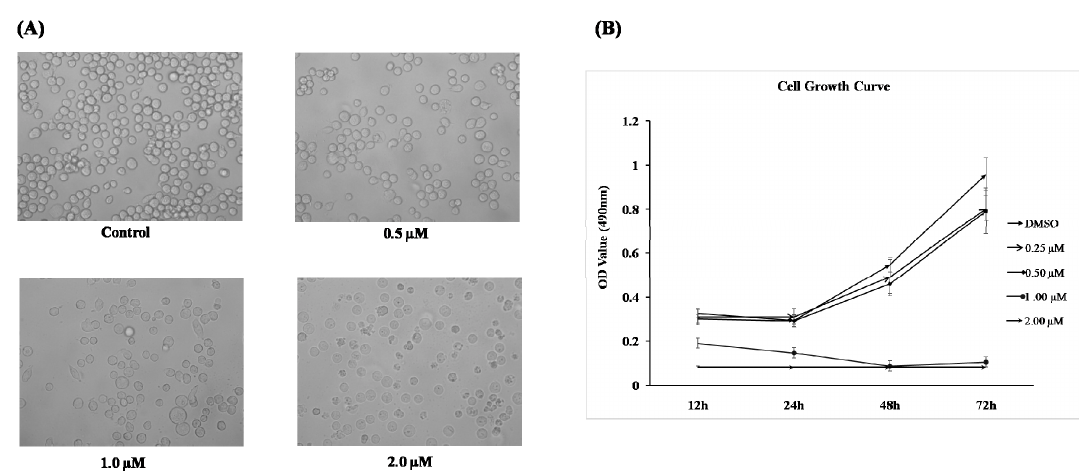
Figure 3. The inhibitory activity on proliferation of human leukemia HEL cell of 3f . ( A ) Cellular morphological alteration of HEL cell at di ff erent concentrations of 3f after 24 h of drug treatment. ( B ) The inhibition of 3f on HEL cell growth after 72